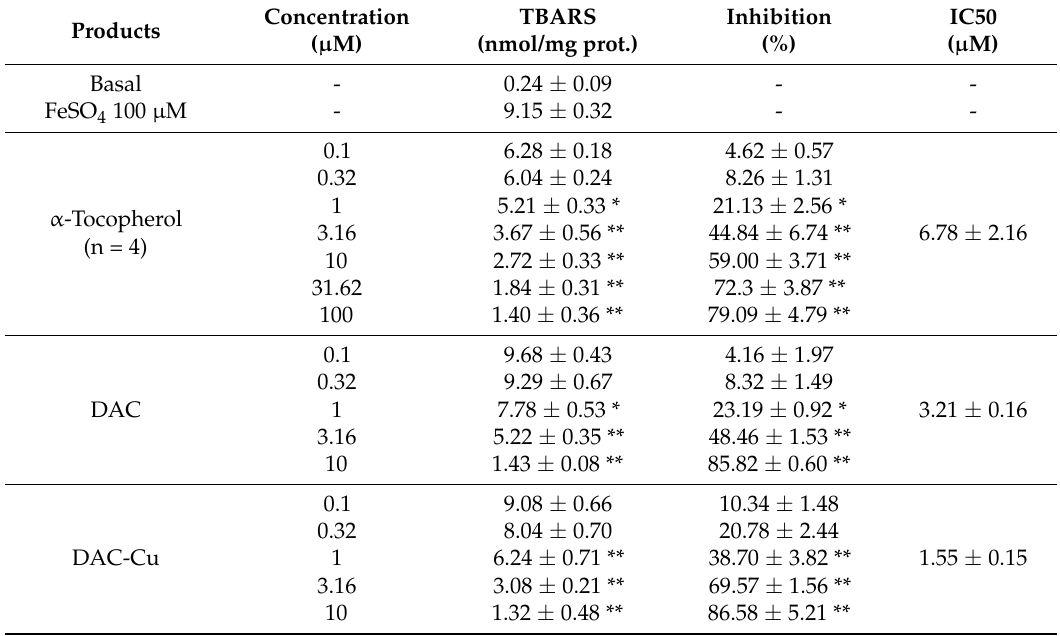
Table 5. Inhibition of lipid peroxidation IC 50 of compounds DAC, DACH, DiMeOC, DAC-Cu, DACH 4 -Cu and